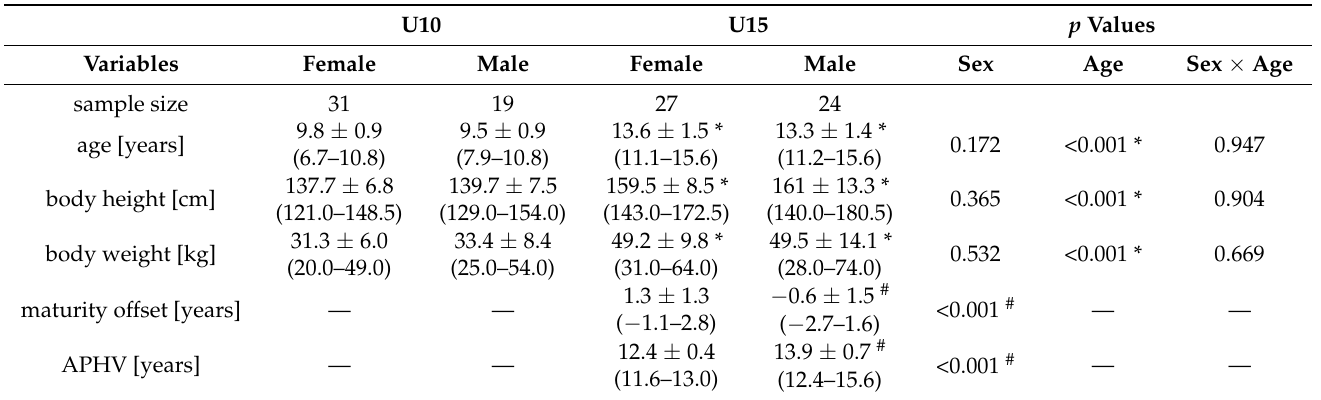
Table 1. Baseline